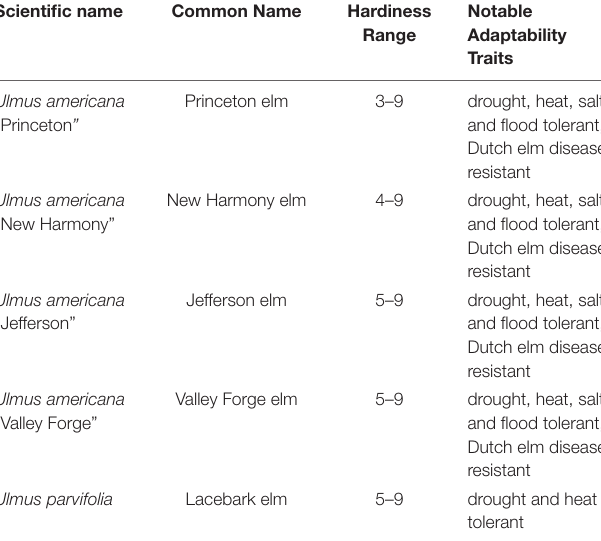
TABLE 6 | Species and cultivars with high adaptive capacity that are currently under-represented in upper Midwestern street tree